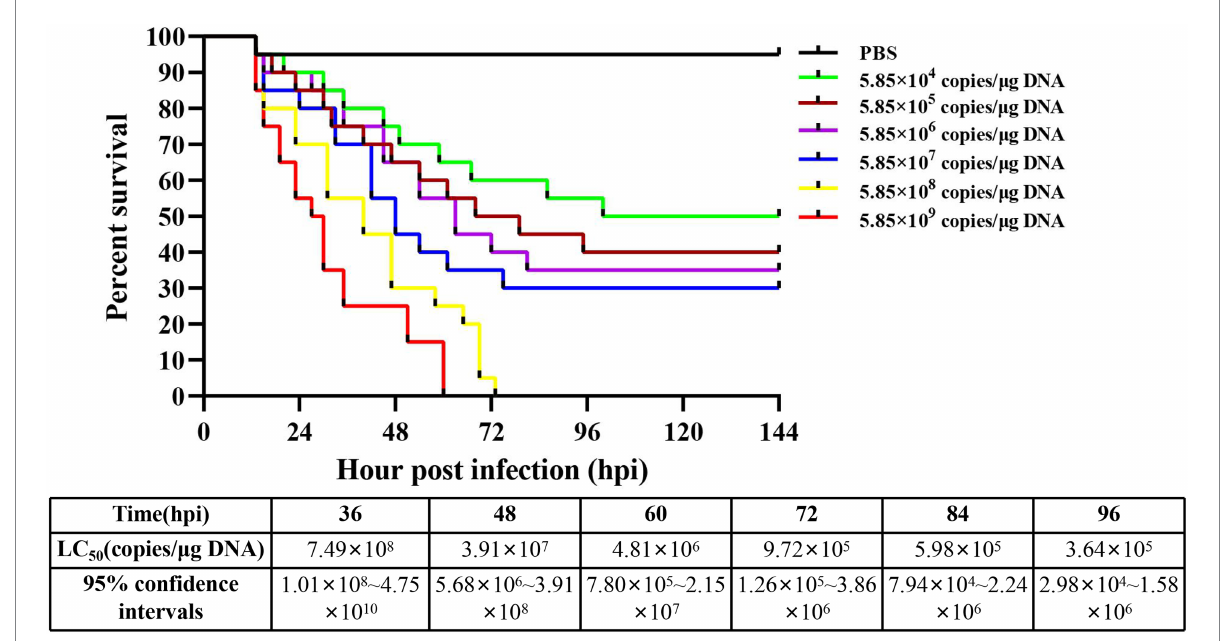
FIGURE 3 Cumulative survival of M. ensis after DIV1 injection and LC 50 test. Seven groups of healthy M. ensis were intramuscularly injected with 50 μ l of DIV1 inoculum at six concentrations and PBS as a